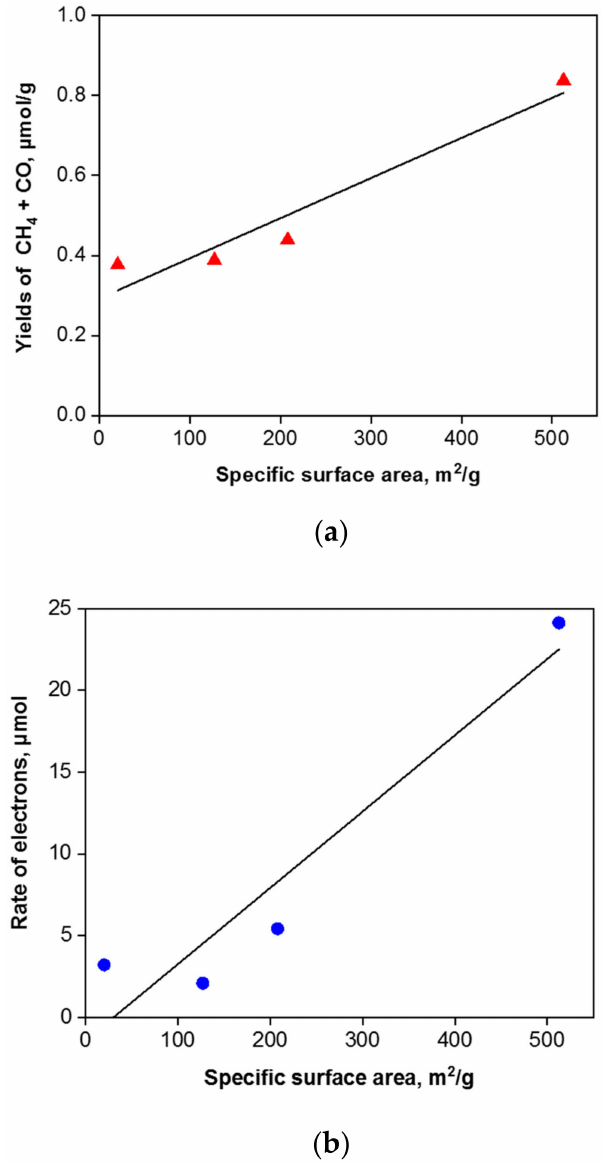
Figure 12. Correlation between the specific surface area and the yields of CH 4 and CO ( a ) and the rate of electron ( b ) in presence of g-C 3 N 4